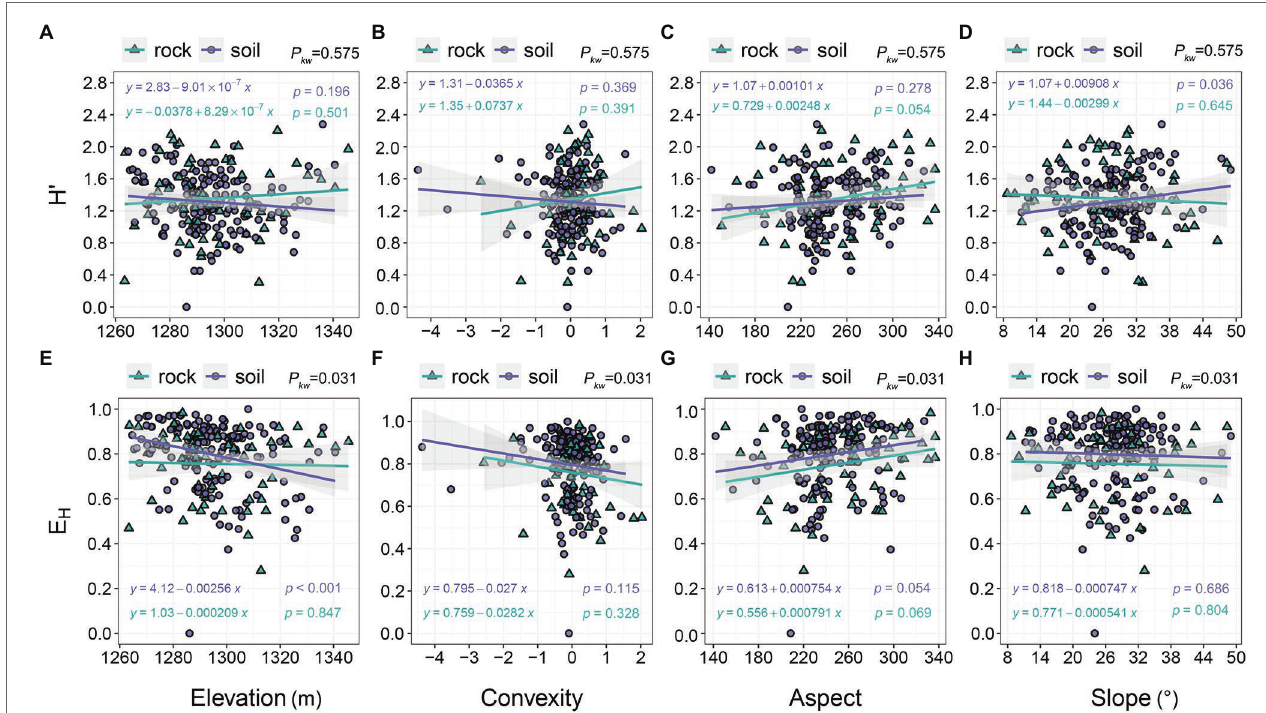
FIGURE 4 | The relationships of H ′ and E H with topographic variables. p kw > 0.05, 0.01 < p kw < 0.05, and p kw < 0.01 represent non-significant, significant, and highly significant differences, respectively. H ′ = ShannonWiener index, and E H = Pielou evenness